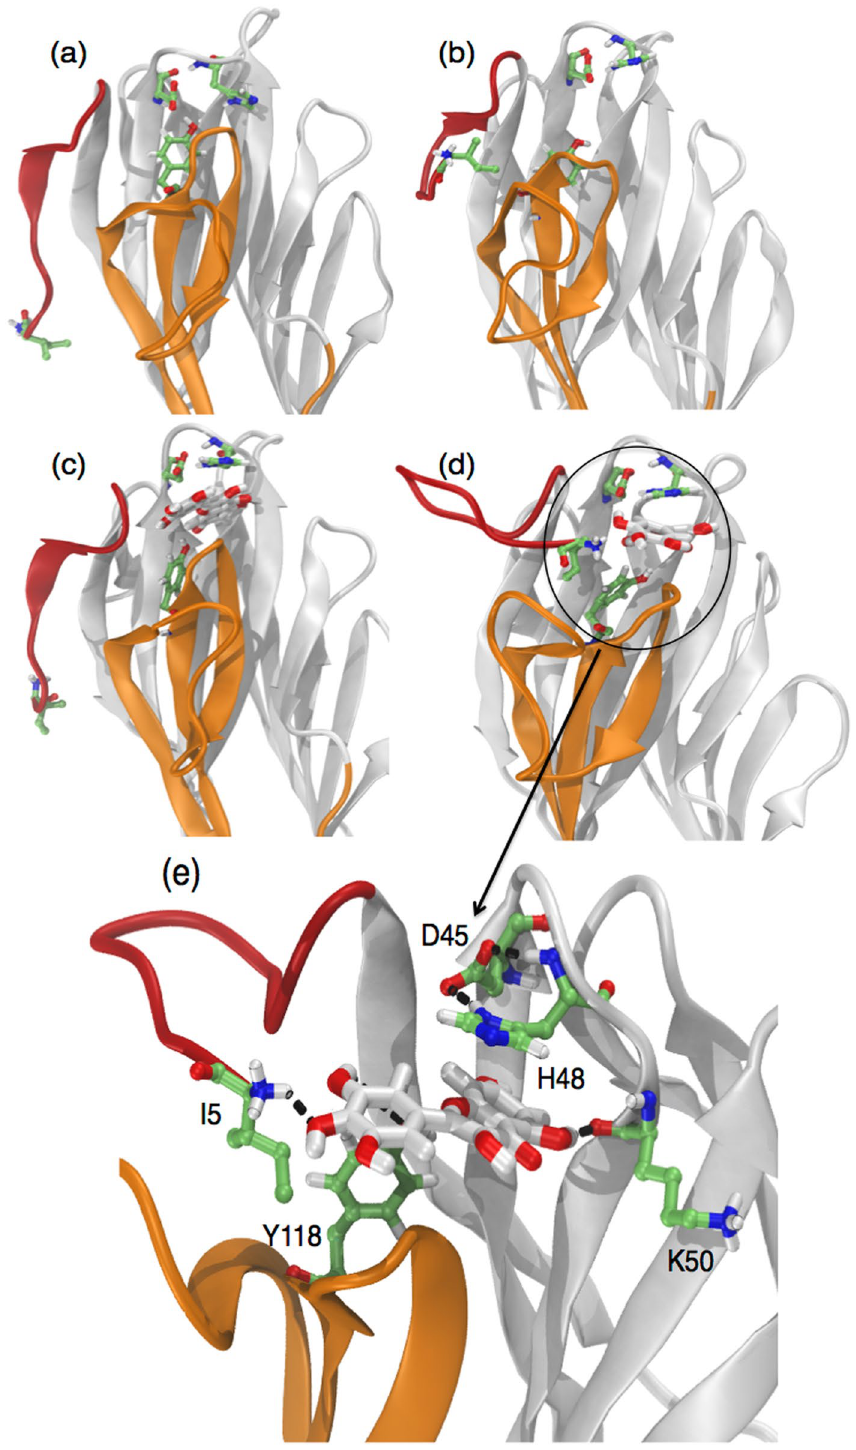
Figure 6. Computational studies of the structural model for the complex Myr- α -hemolysin (Hla). Initial and final conformations of free ( a , b ) and Myr-bound ( c , d ) Hla obtained from MD simulations in explicit solvent and molecular docking calculations. ( e ) Detailed view of chemical groups and residues involved in the binding of Myr to Hla. The amino latch is colored in red, and the prestem in orange. Receptor residues are shown in green sticks and Myr in white sticks. Hydrogen bonds are represented by black dashed lines. Methodology can be found in Supplementary